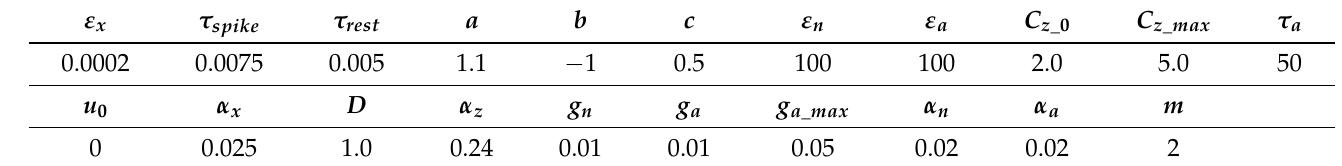
Table 2. The adjusted set of model